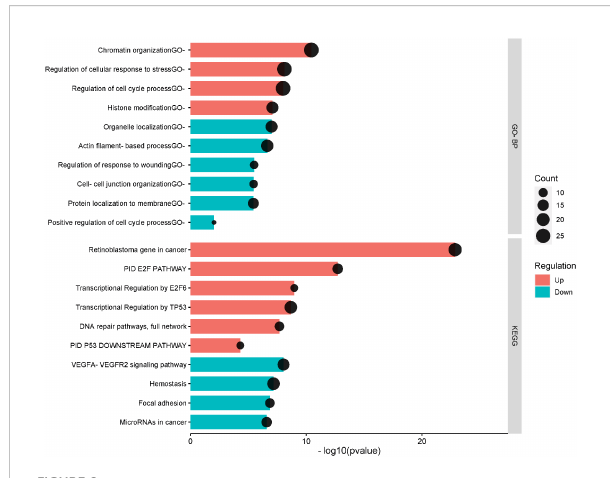
FIGURE 2 The top signi fi cantly enriched Gene ontology biological process and KEGG pathways of the differentially expressed genes in HPV+ compared to HPV- HNSCC patients. The pathways are presented in the red shade for the upregulated and the blue shade for the down- regulated. The vertical axis is the GO-BP: GO Biological Processes or KEGG: KEGG Pathway term. The horizontal axis is the transformed p-value (-log10pvalue). The count presents the genes count in the corresponding terms.